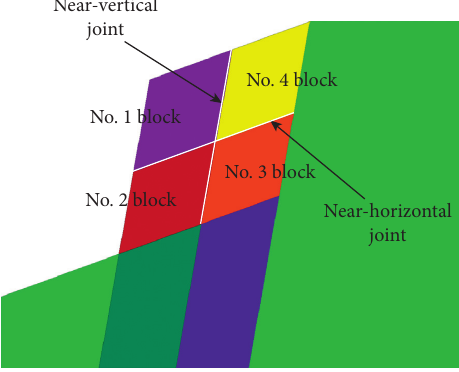
Figure 7: The numerical model of joint slope. Table 4: Rock mass parameters in numerical